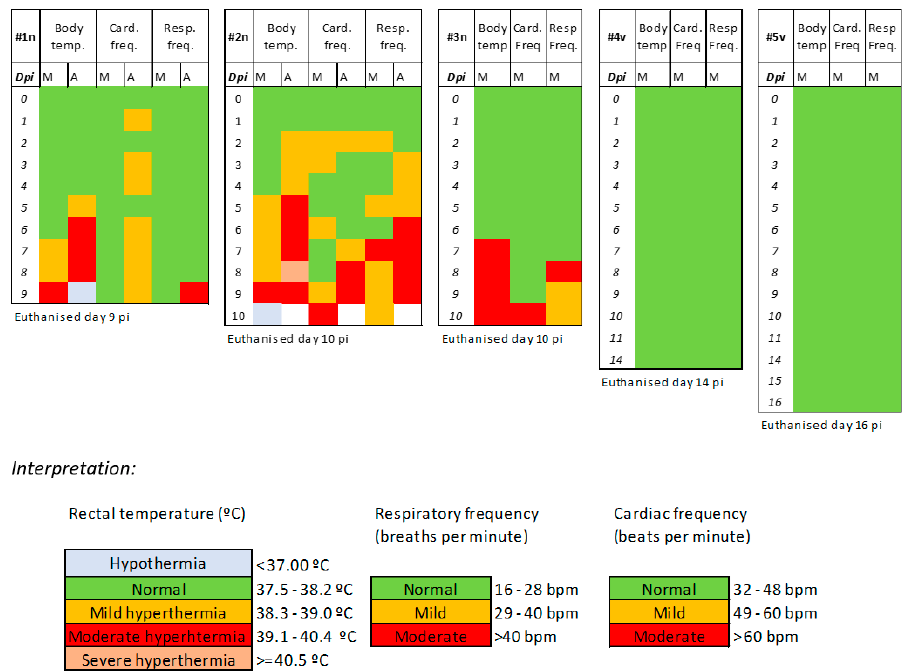
Figure 2. Clinical monitoring of horses (Infection